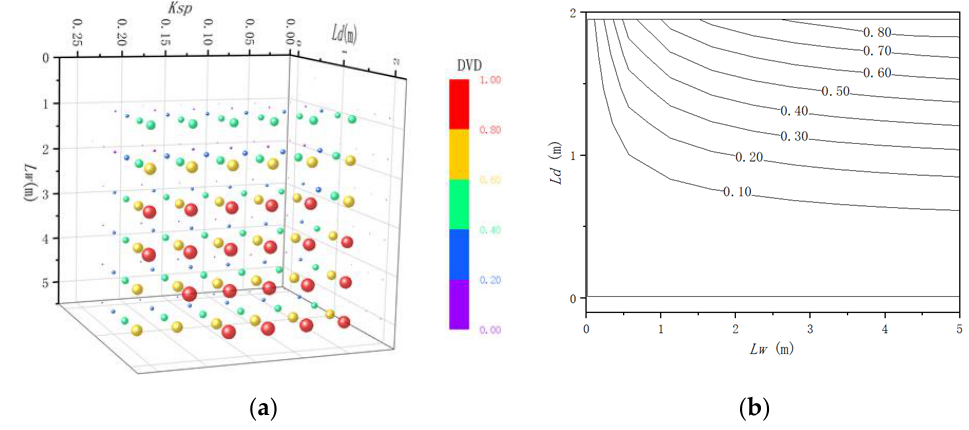
Figure 5. Drainage volume detention rate (DVD) of off-line ditch-pond system under different combinations of 𝐿 𝑑 , 𝐿 𝑤 , and 𝐾 𝑠𝑝 . ( a ) Three-parameter combinations; ( b ) Two-parameter combinations ( 𝐾 𝑠𝑝 = 0.05).